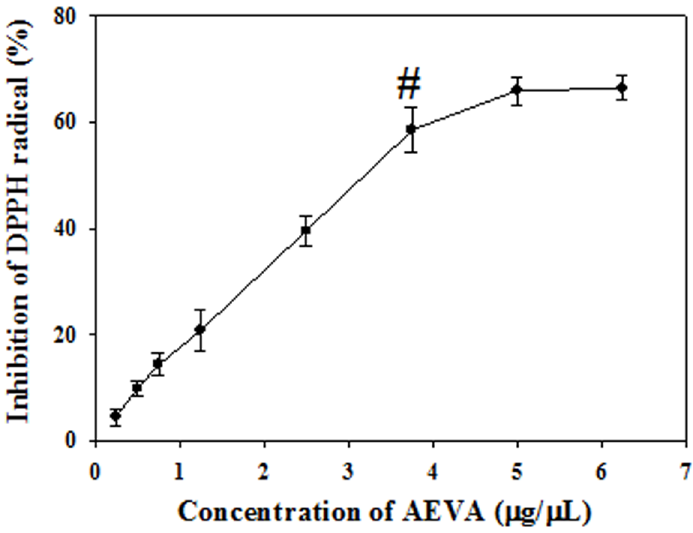
Fig 3. DPPH radical scavenging activity of AEVA. Graph is obtained by plotting different concentrations of AEVA (0.25, 0.5, 0.75, 1.25, 2.5, 3.75, 5, and 6.25 μ g/ μ L) against the percent inhibition. “ # ” indicates the optimum concentration of AEVA at which it exhibits maximum inhibition. Values are mean ± SE (n =